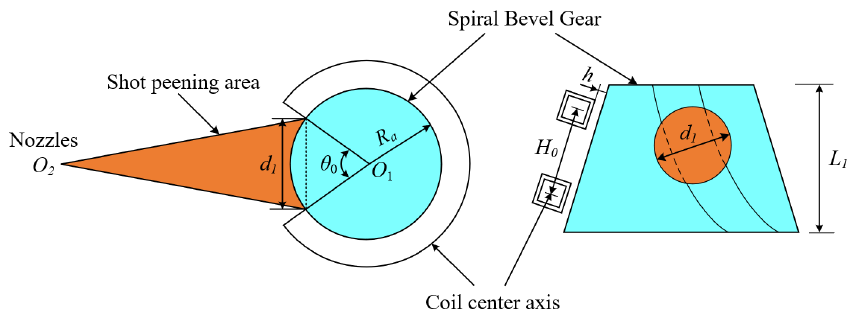
Figure 2. Assembly relationship between the spiral bevel gear and induction heating coil.